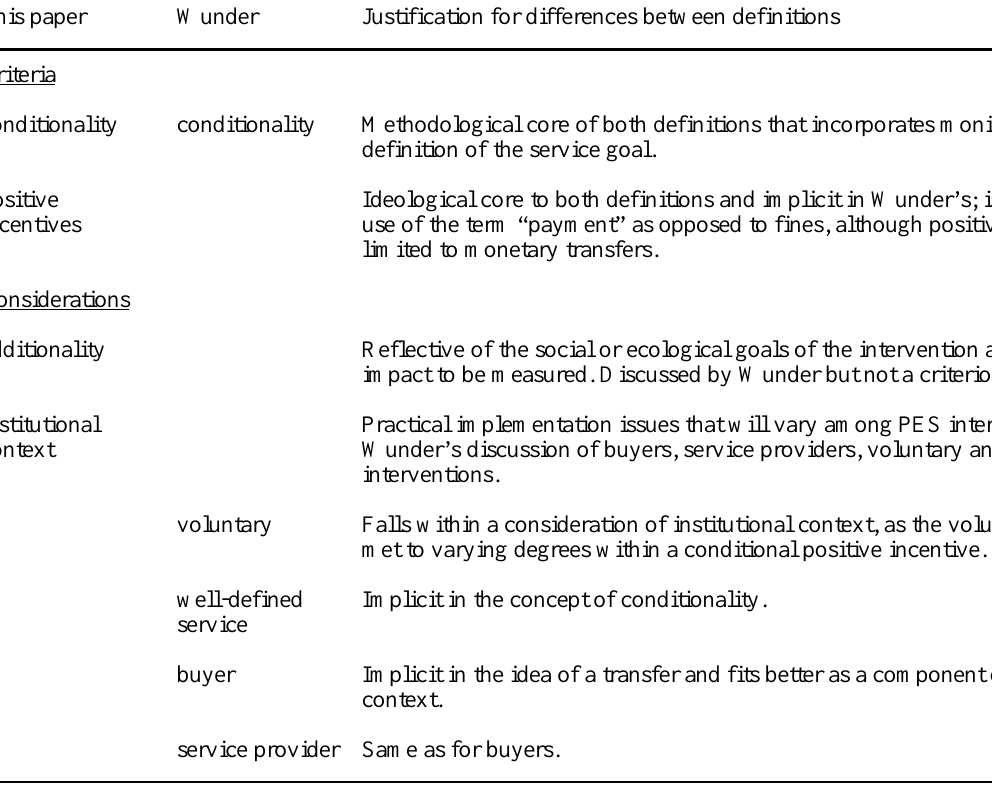
Table 1. Comparative list of the criteria for PES from Wunder (2005) and of criteria and considerations from this paper with justifications for the changes made in this